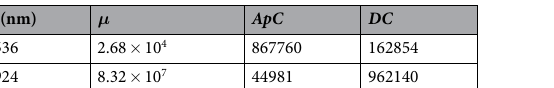
Table 2. Counts due to thermal dark noise ( DC ) and afterpulsing ( ApC ), extracted from Fig. 3 and corrected for the saturation effect. ( ApC + DC ) is greater than 10 6 owing to this